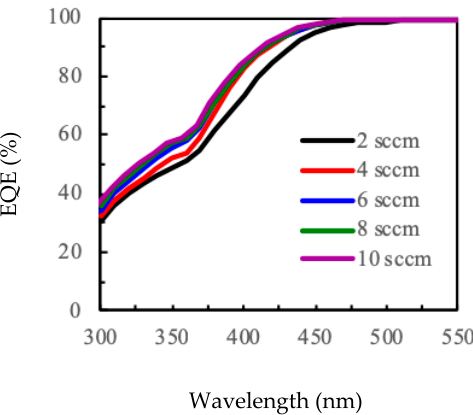
Figure 4. Simulated external quantum efficiency (EQE) spectra in 300–550 nm for crystalline silicon heterojunction (SHJ) solar cells with different p-type emitters.